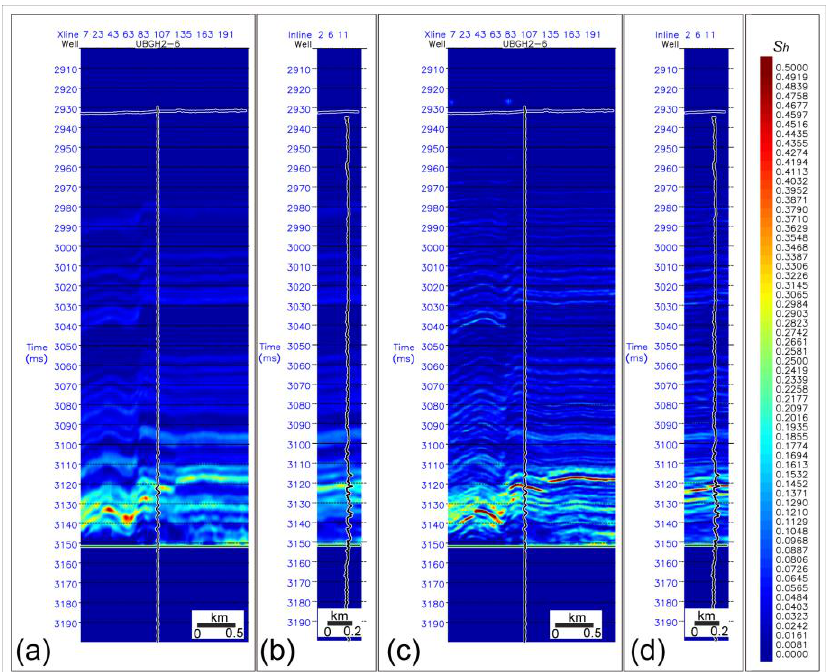
Figure 10. GH saturation estimated with Equation (5) for ( a ) inline 13 and ( b ) crossline 102 of C3DS and ( c ) inline 13 and ( d ) crossline 102 of H3DS crossing the UBGH2-6 well.